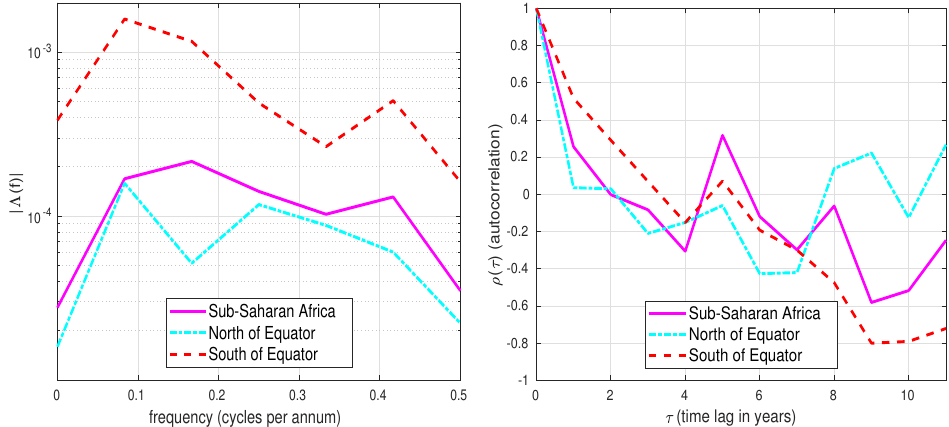
Figure 6. Graphs of the power spectrum as a function of frequency and autocorrelation as a function of lag time applied to the time series of the proportion of the burnt area for aggregated vegetation types in sub-Saharan